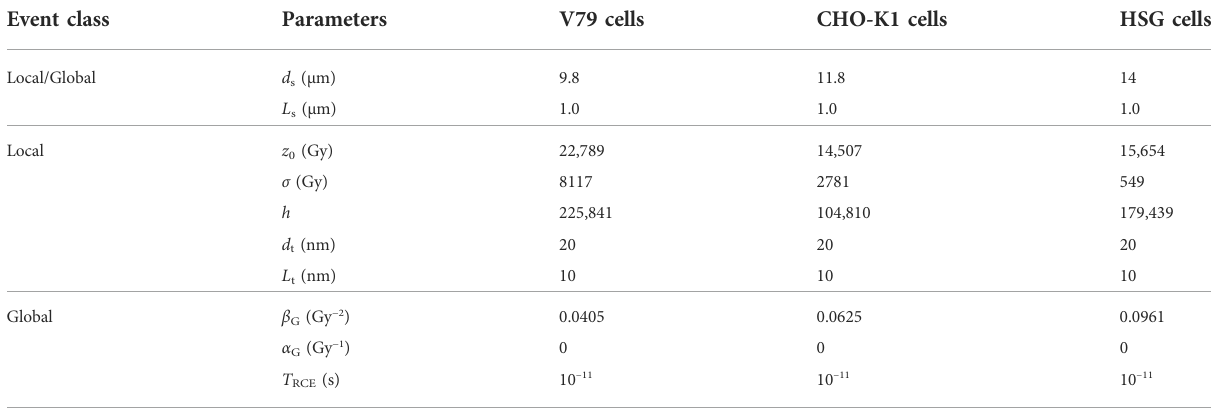
TABLE 1 Values of the parameters used to model the cell lines V79, CHO-K1 and HSG with NanOx. d s and L s represent the sensitive volume diameter and length, respectively.Similarly, d t and L t arethe local targets ’ diameter and length, respectively. T RCE is the time at which the concentrationof (cid:129) OH radicals is considered.